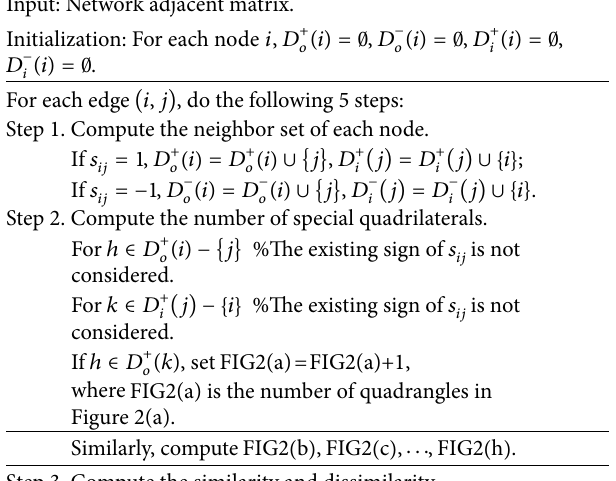
Table 4: Three extracted